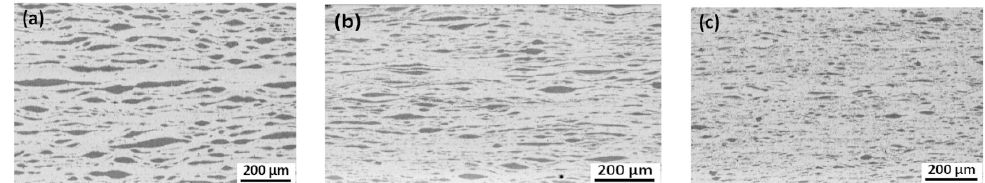
Figure 8. SEM micrographs of the ARB processed Cu/Ti bimetal composite after ( a ) 5 cycles, ( b ) 7 cycles, and ( c ) 9 cycles. Reprinted with permission from ref. [86]. Copyright 2017 Elsevier.